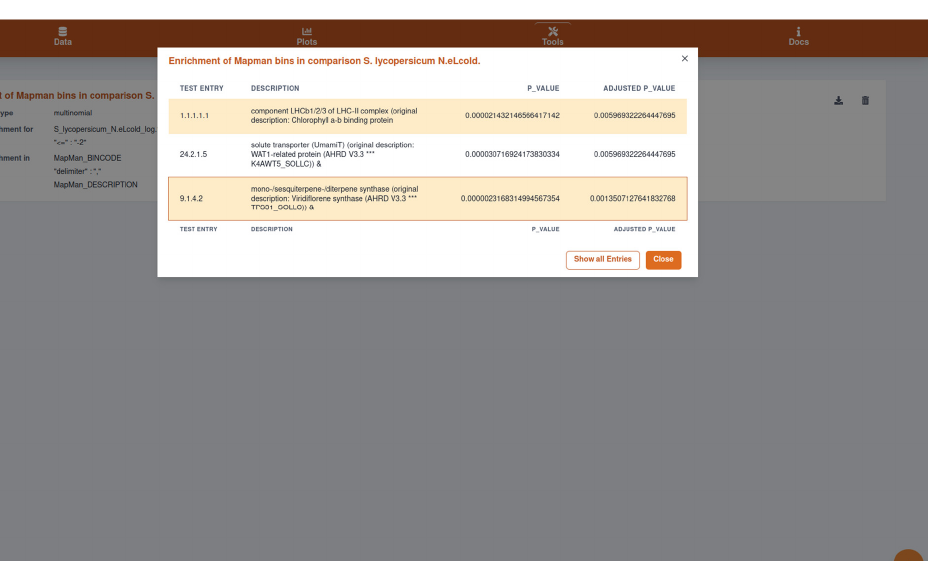
Figure 5. Screenshot of the result of an enrichment analysis (EA) carried out on the example data. This analysis is available in the “Tools” menu (screwdriver and wrench icon in the top panel). In the lightly faded-out background, the carried-out enrichment analysis can be seen. If more such analyses were done by clicking on the round plus icon in the bottom-right corner, they would also appear in this list. Clicking on the respective analysis opens the table shown in the highlighted foreground overlay. In it, the user is presented with significant results, while the button in the bottom-right corner “Show all Entries” enables the inspection of all, not only the annotations significantly tested for overrepresentation. In the shown example, the EA identified molecular gene functions overrepresented among genes whose expression is down-regulated in S. lycopersicum in response to the applied stress treatments, a combination of nitrogen deficiency (N-), chilling temperatures (cold), and elevated light intensity (eL). In this case, the results support the observation made for the example data earlier in Figure 4a,b, i.e. the response to stress treatments in the form of down-regulation of genes associated with (i) photosynthesis and (ii) terpene and carotene biosynthesis. Among the down-regulated genes, the molecular functions (i) “Chlorophyll a-b binding protein” in the “LHC-II complex” (Mapman Bin 1.1.1.1.1) and (ii) “UmamiT solute transporter” (Mapman Bin 24.2.1.5), a “sesquiterpene synthase”, and “diterpene synthase” (Mapman Bin 9.1.4.2) are significantly overrepresented (all adjusted p -values < 0.006). Thus the Mapman plots and enrichment analyses truly help to elucidate the genetic response in S.